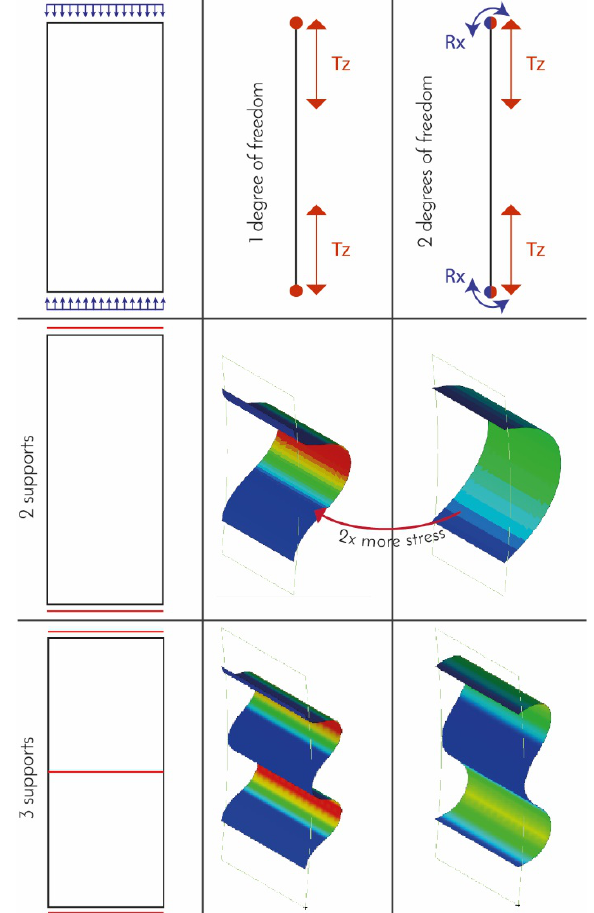
Fig. 9 Example of analysis of the combination of movement and supports investigation. Two edges translation with one or two degrees of freedom. (Ribeiro Silveira